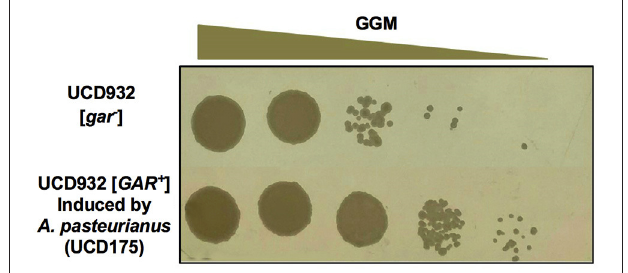
FIGURE 4 | Induction of [ GAR + ] prion by bacteria is heritable. Growth of retested Saccharomyces UCD932 strain from a colony adjacent to Acetobacter pasteurianus UCD175 strain on GGM plate after passage through nonselective